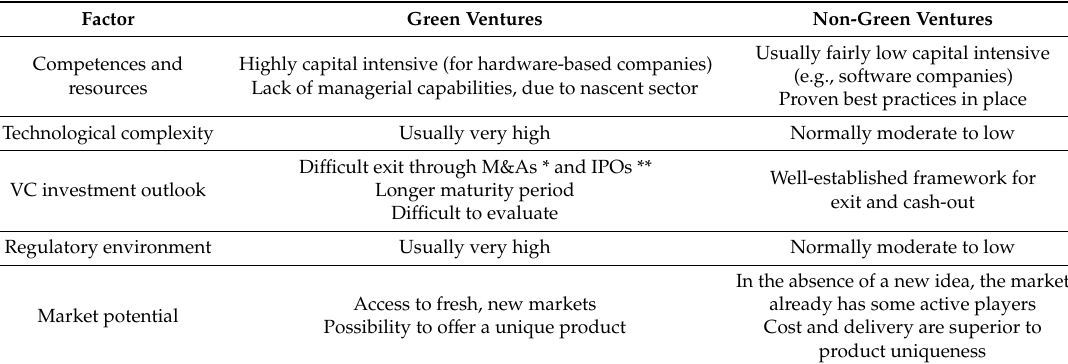
Table 1. Comparative view of green ventures vs. non-green